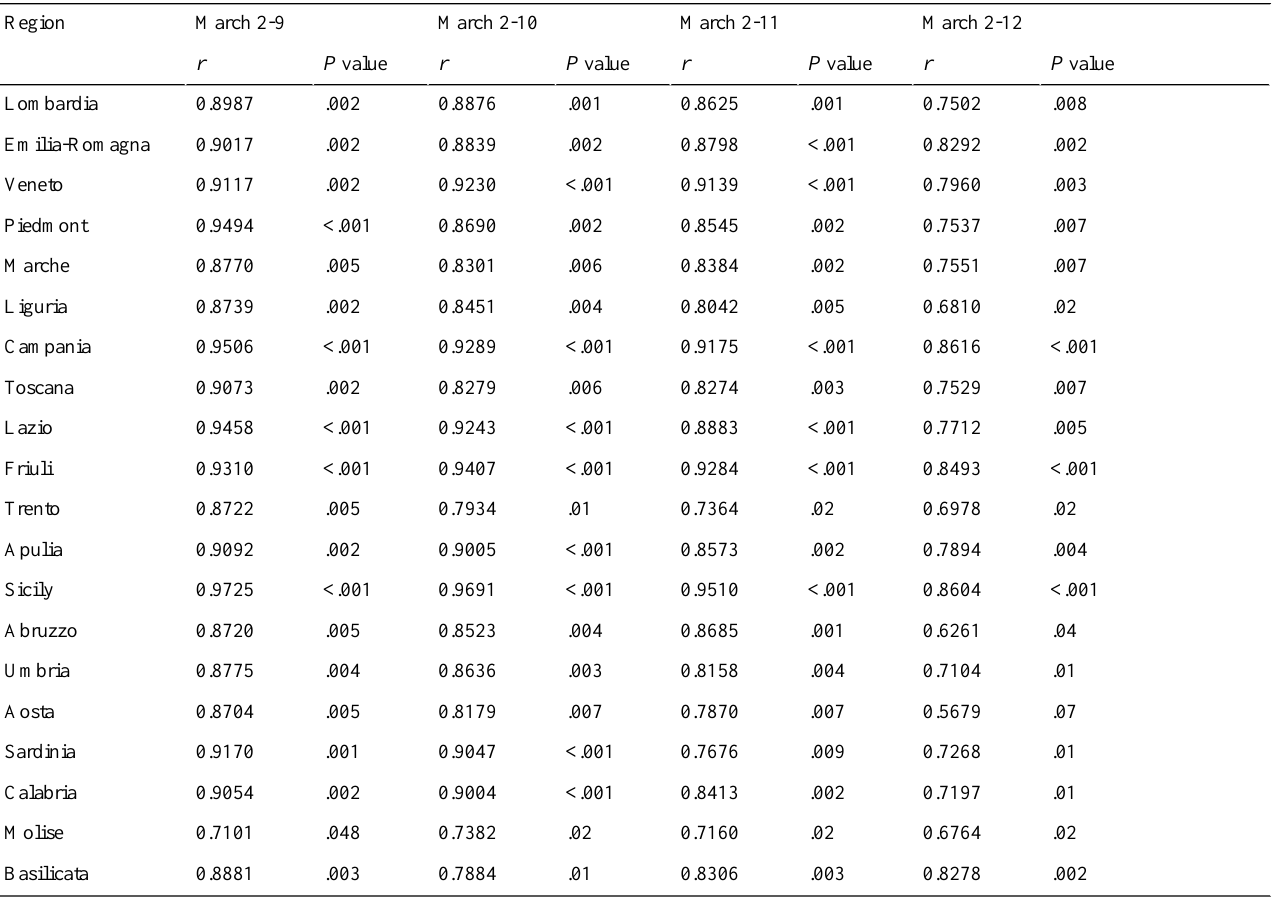
Table 3. Pearson correlation coefficients ( r ) between COVID-19 cases and Google Trends data in the 20 Italian regions for March 2-9; March 2-10; March 2-11; March